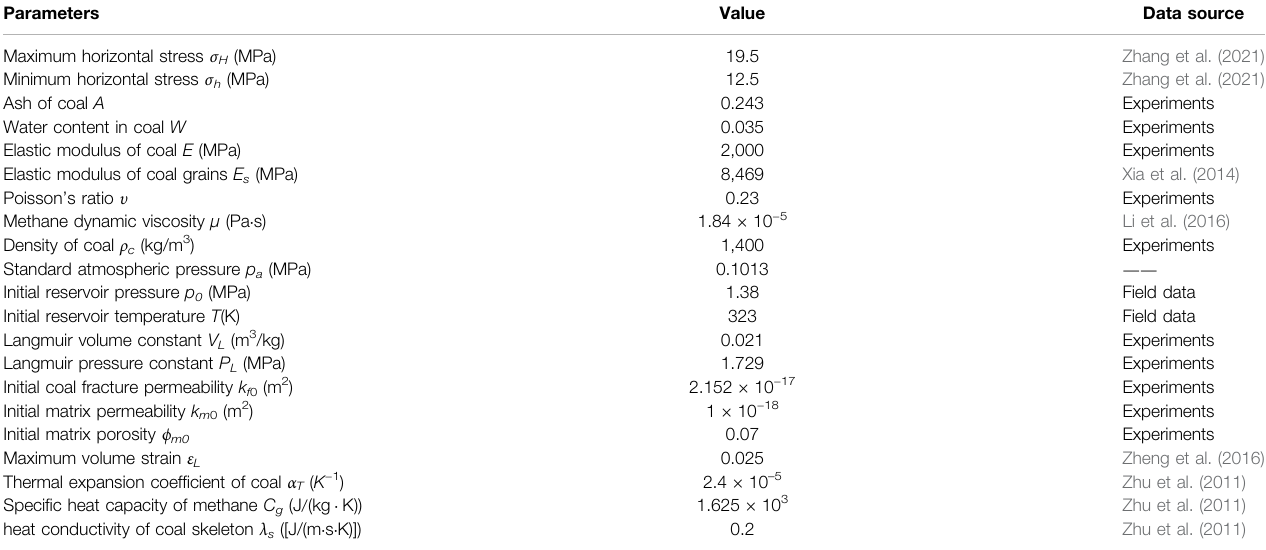
TABLE 1 | Input parameters used in the numerical